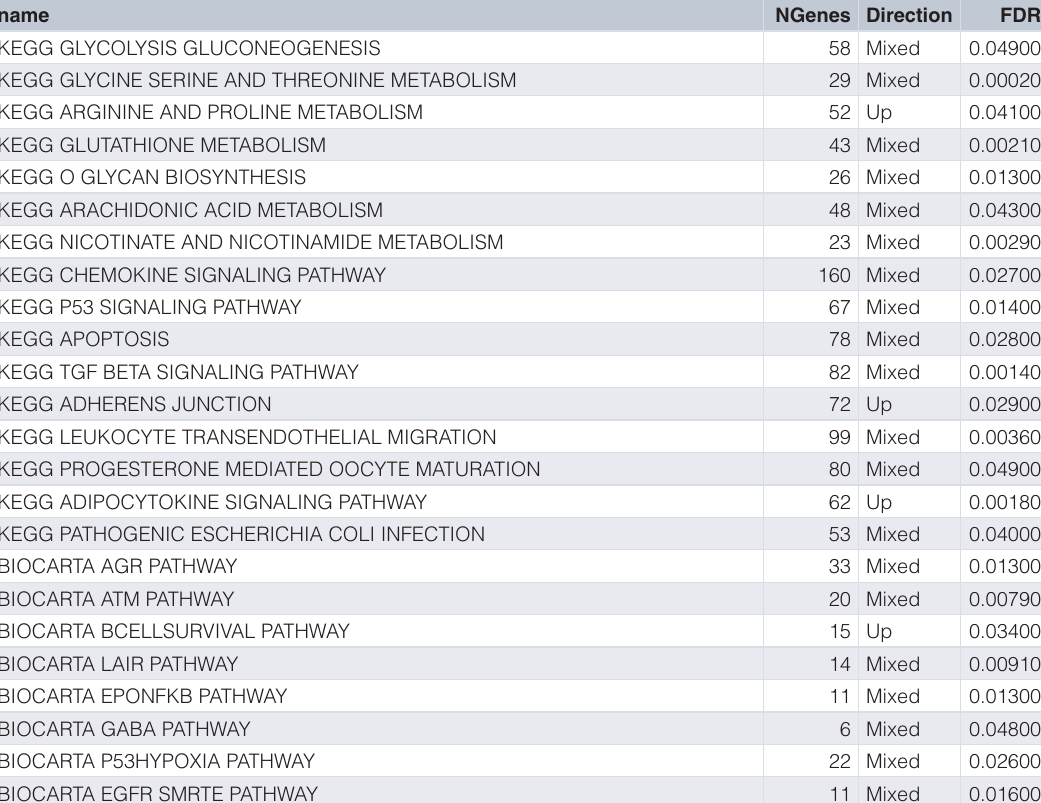
Table 1. List of all singletons, i.e., genesets without sufficient overlap with any other geneset.